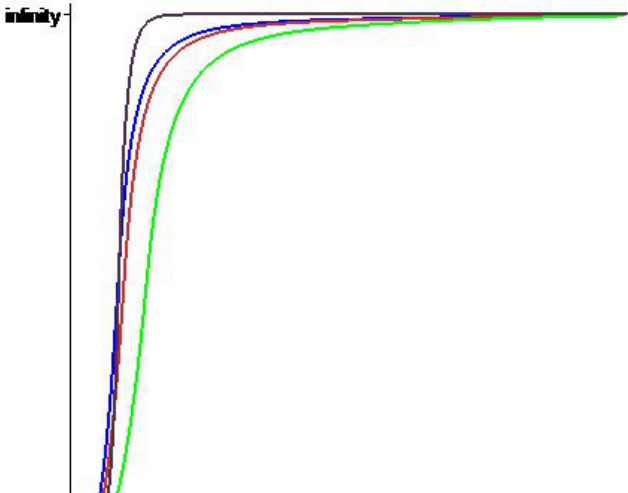
Figure 3. Comparison of the approximations by K G (cid:0) v ; x , σ 2 n = 1 K G 200 on [ 0, ∞ ) .